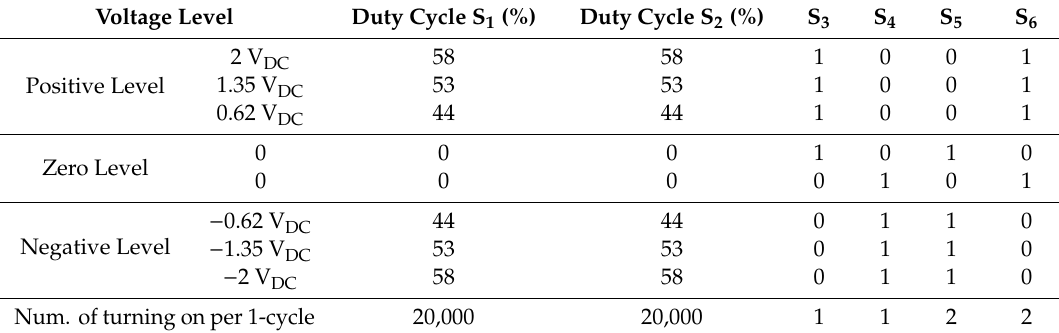
Table 9. Switching table level = 7, gain =